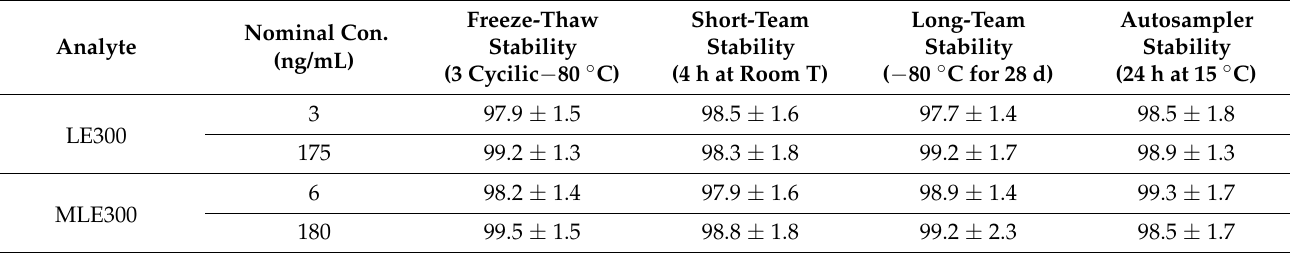
Table 6. Stability of LE300 and